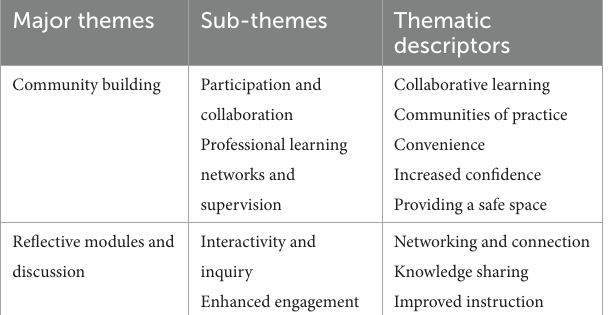
TABLE 4 School leaders’ responses: themes and